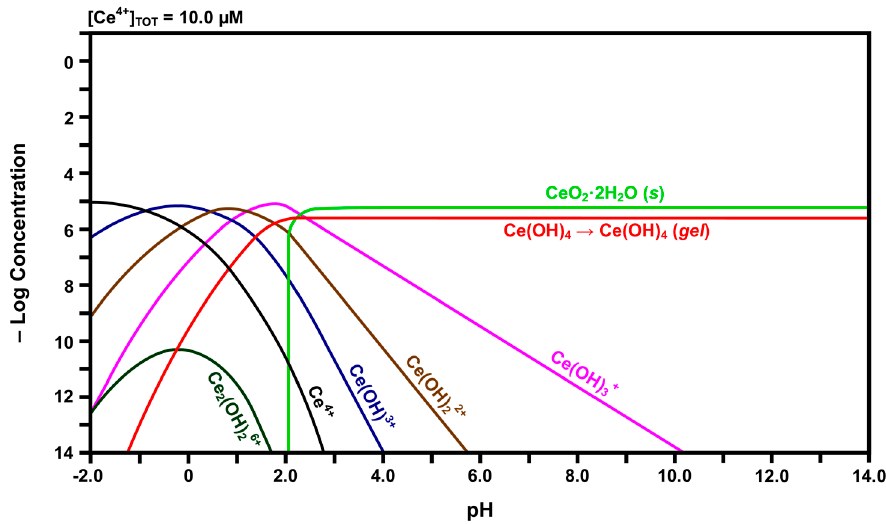
Figure 4. Calculated speciation diagram of Ce 4+ -H 2 O.